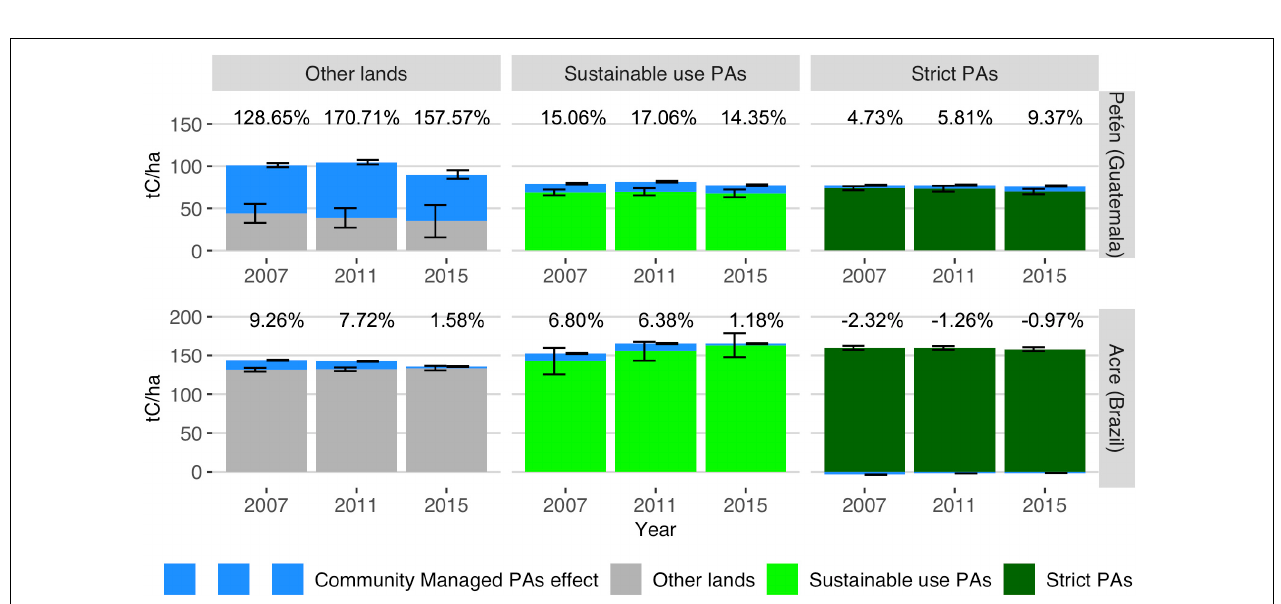
FIGURE 3 | The temporal effects of Community Managed PAs on carbon stocks in Petén (Guatemala) and Acre (Brazil). Significant ( p < 0.05) temporal effects are represented as blue bars and percentages, indicating the additional/fewer carbon stocks secured by Community Managed PAs relative to the carbon stocks baselines of Other Lands (gray), Sustainable Use PAs (light green), and Strict PAs (dark green). Error bars indicate 95% confidence intervals for the baselines and temporal effects.